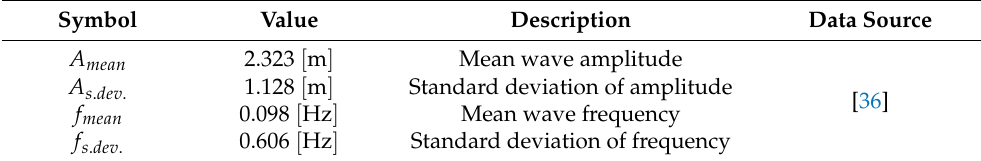
Table 4. Input values for the random wave generation.